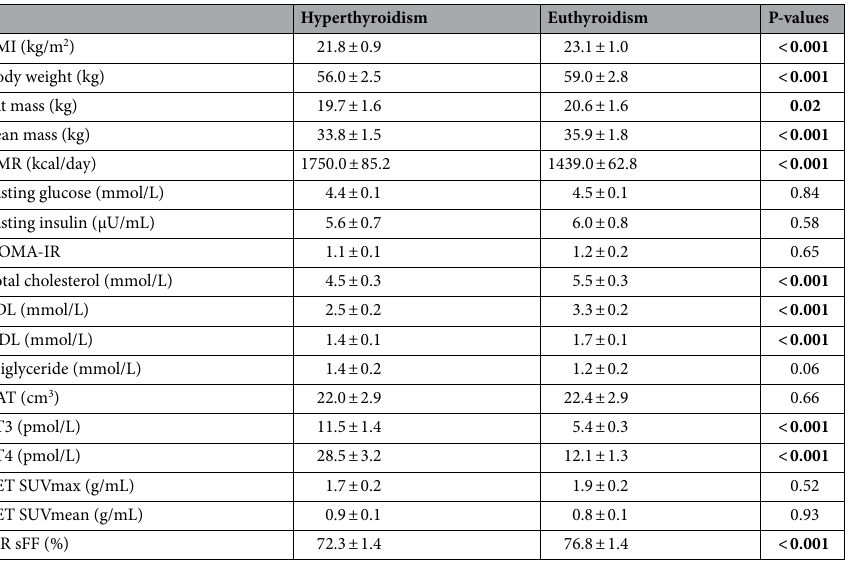
Table 1. Characteristics of total participants during hyperthyroidism before treatments and early euthyroidism states. N = 22. Data presented as mean ± SEM. P values represents Student’s t -test between hyperthyroidism and early euthyroidism, phases. N = 21 for PET SUV, MR FF and VAT data. Statistically significant values are shown in bold. BMI, body mass index, was calculated as body weight (kg) divided by the square of height (m) RMR resting metabolic rate, HOMA-IR homeostasis model assessment of insulin resistance, was calculated as fasting glucose*fasting insulin divided by 22.5, LDL low-density lipoprotein, HDL high-density lipoprotein, VAT visceral adipose tissue, FT3 free triiodothyronine, FT4 free thyroxine, PET positron emission tomography, MR magnetic resonance, SUV standardized uptake value, sFF supraclavicular fat fraction.